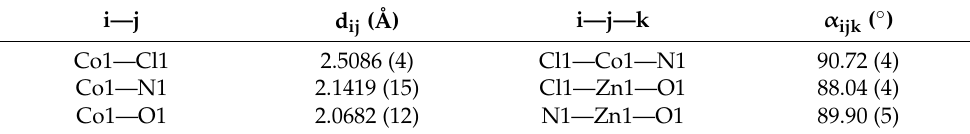
Table 4. Hydrogen bonds and π -stacking interactions in the structures of C1. Each ring is indicated by one atom, which belongs solely to this ring. α is the dihedral angle between planes I and J, β is the angle between Cg(I)–Cg(J) vector and normal to plane I, and d p is the perpendicular distance of Cg(I) on ring J Figure 6. Molecular packing in C1 showing π -stacking interactions: view on a π -stacking layer ( a ); view along a axis ( b ).